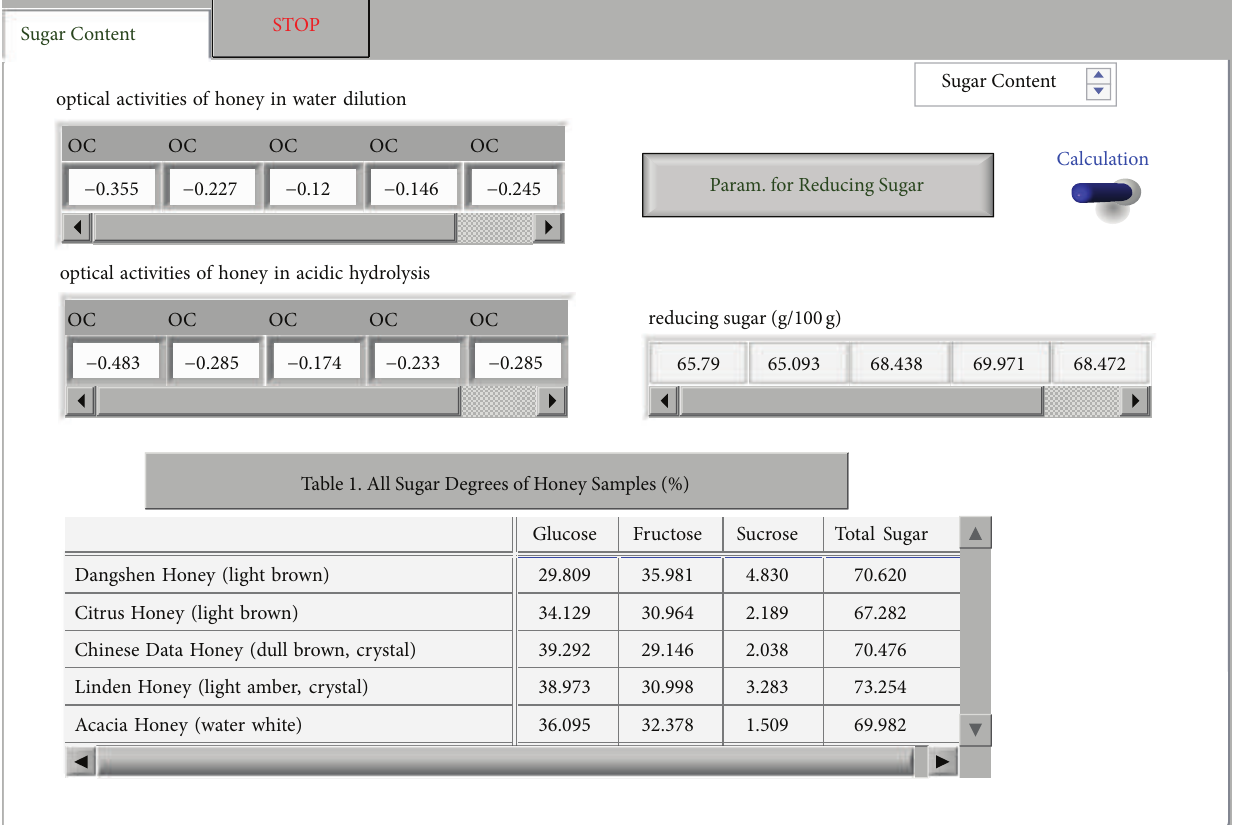
Figure 4: Panel for the sugar degree